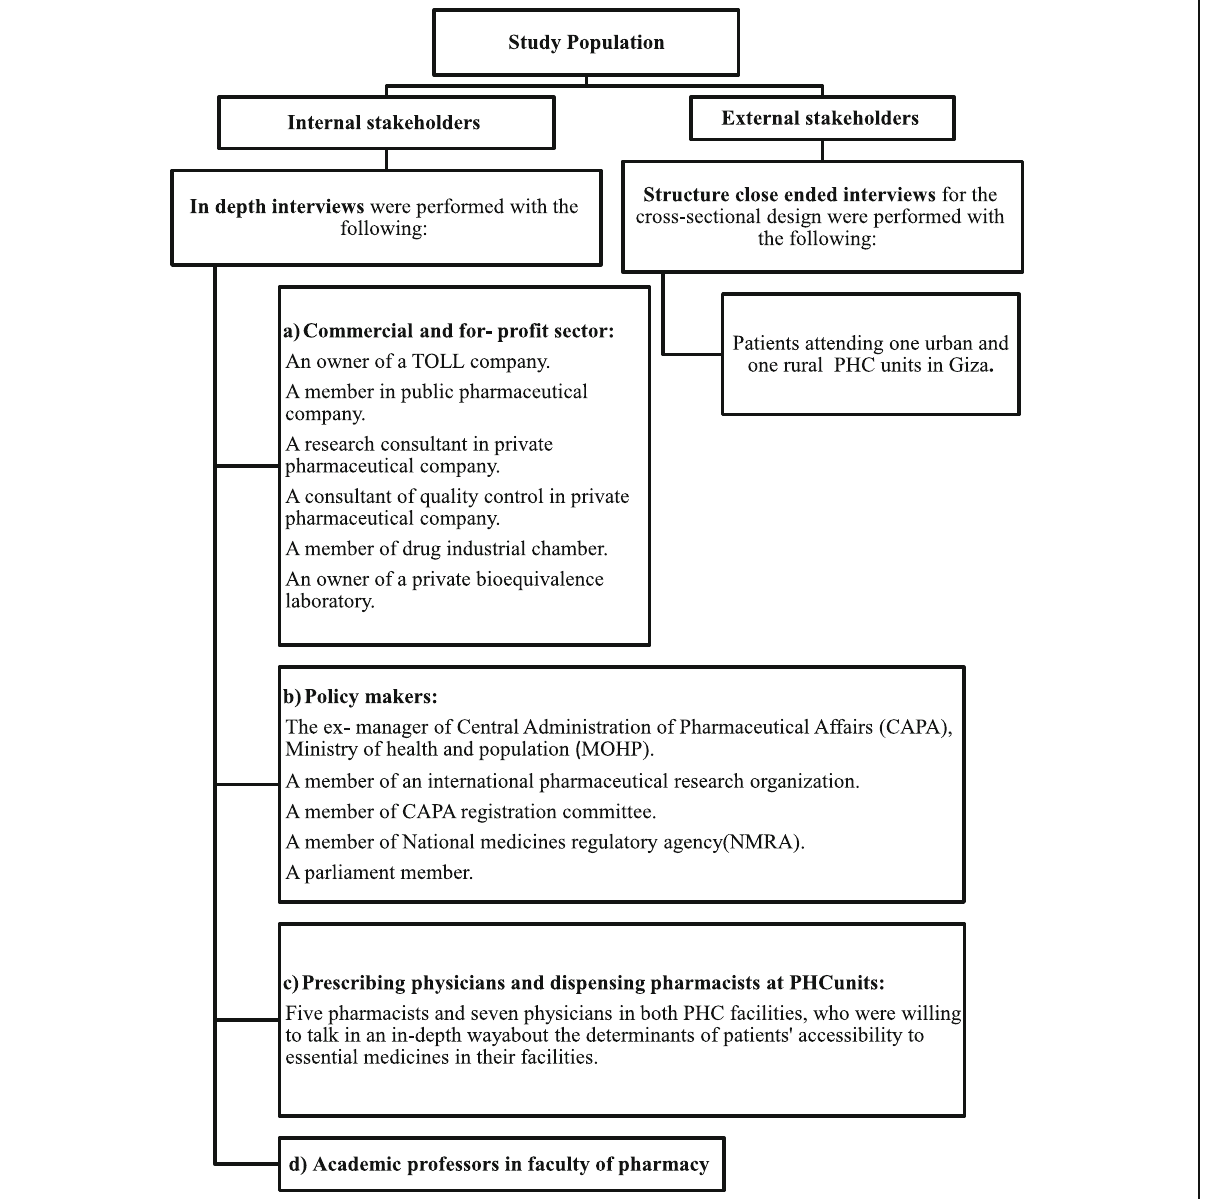
Fig. 1 Internal and external stakeholders of the pharmaceutical